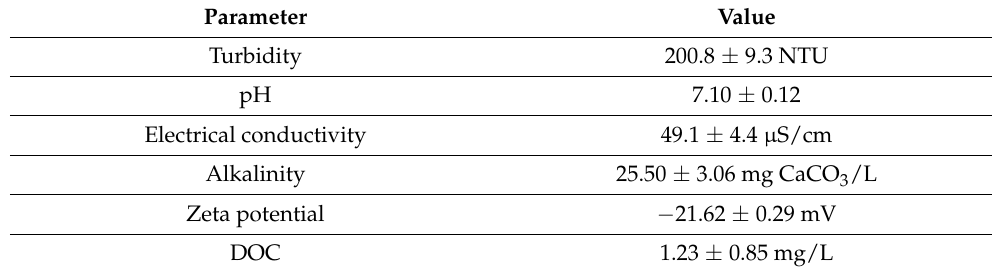
Table 1. Characteristics of tested turbid